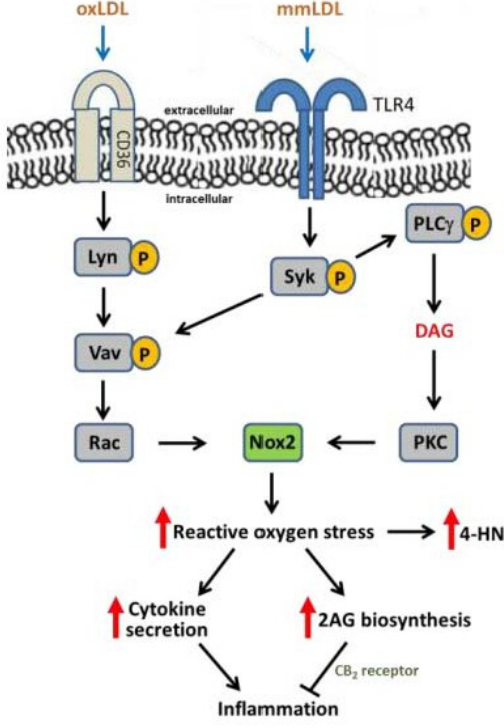
Figure 3. Signaling pathways in macrophages responsible for activation of NADPH oxidase caused by exposure to oxidized (ox)LDL and minimally modified (mm)LDL. Abbreviations: CD36 , scavenger receptor; TLR4 , toll-like receptor 4; Lyn and Syk , Src family tyrosine kinases; Vav , guanine nucleotide exchange factor; Rac ,